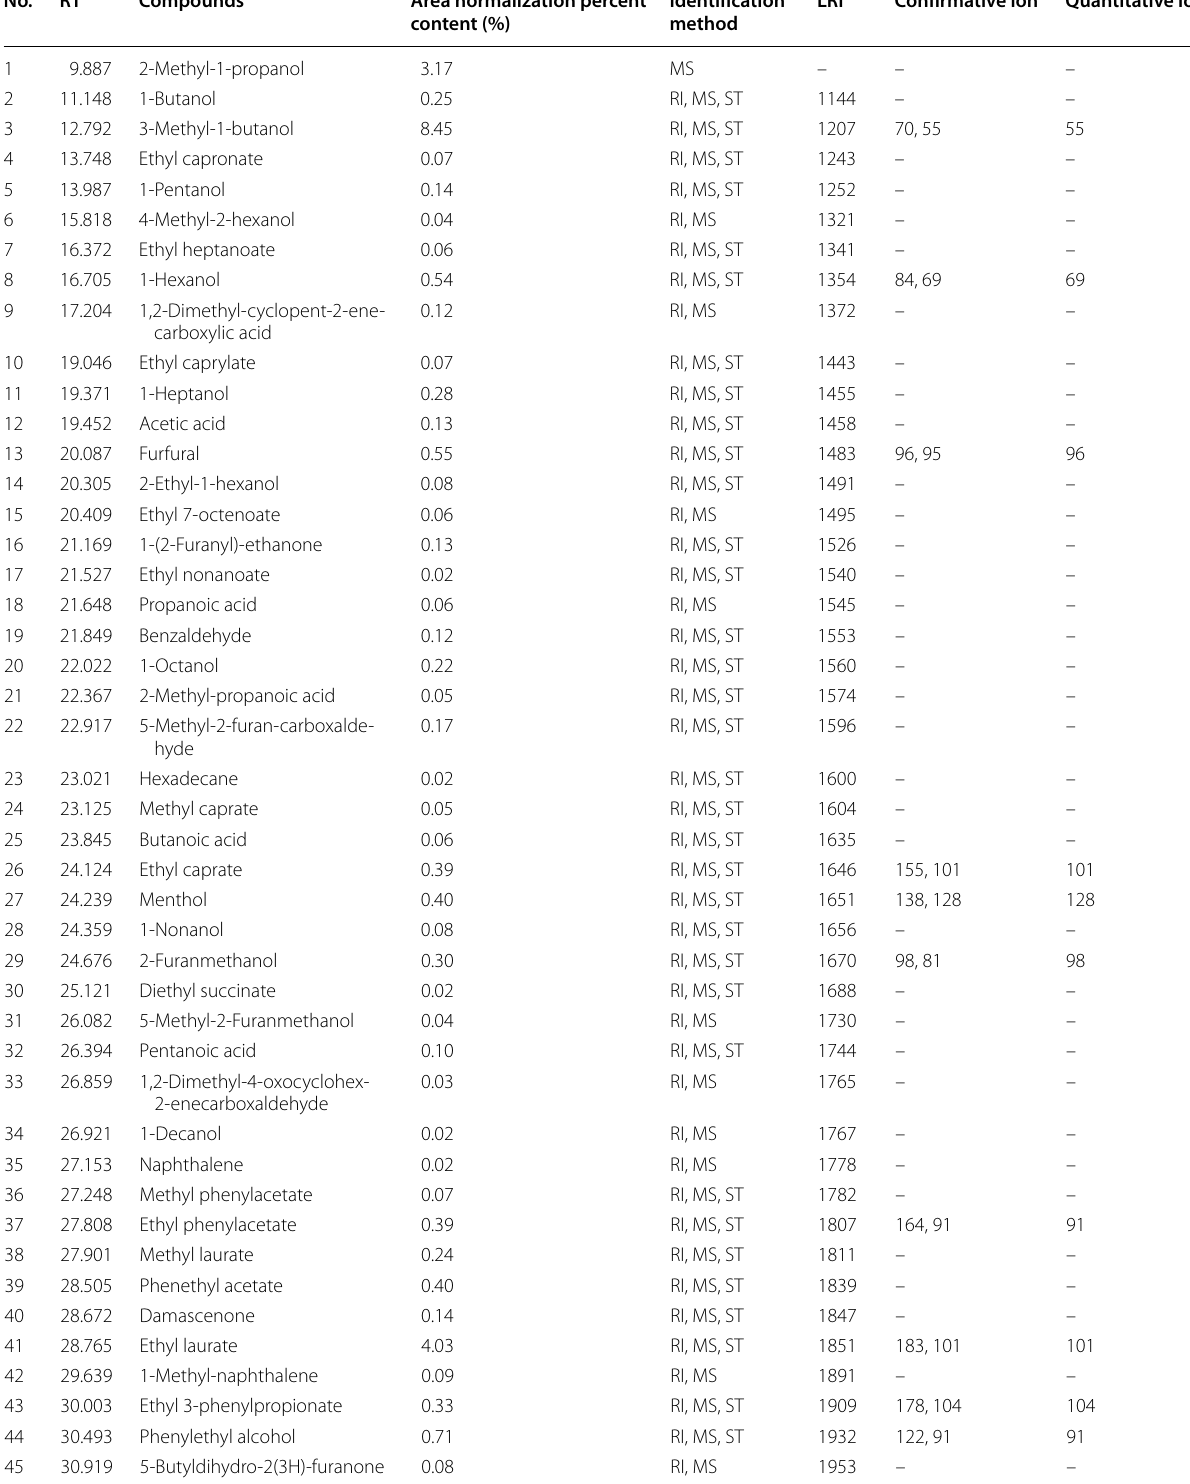
Table 1 Retention time, linear retention index, area normalization percent content of the volatile components in jujube extract identified by the S3DE/GC–MS and confirmative ion and quantitative ion of the selected compound for quantita- tive